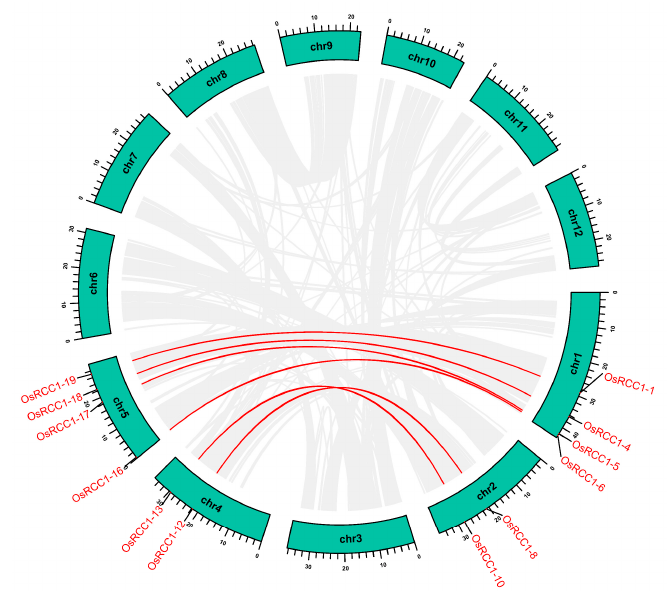
Figure 5. Segmental duplication events of OsRCC1s . Segmental duplicated OsRCC1 gene pairs are linked by the red lines between chromosomes. Segmental duplicated gene pairs within the rice genome are linked by the gray lines. The chromosome numbers are shown at the center of each chromosome. The scale bar marked on the chromosome indicates chromosome lengths (Mb).